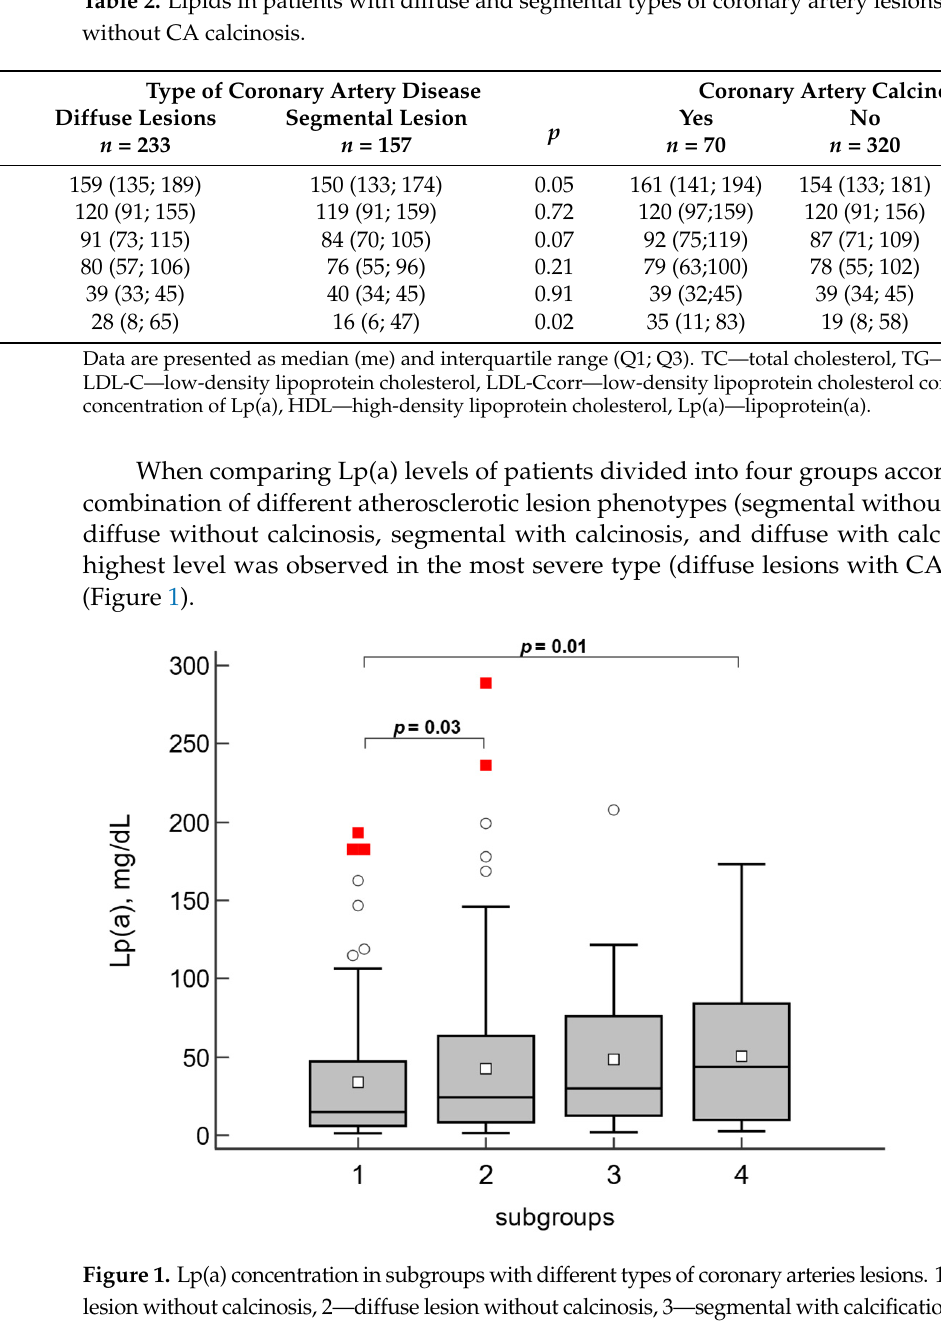
Figure 1. Lp(a) concentration in subgroups with different types of coronary arteries lesions. 1—segmental lesion without calcinosis, 2—diffuse lesion without calcinosis, 3—segmental with calcification, 4—diffuse with calcinosis. The data are presented as Box and Whisker graph. The circles indicate values outside the Q3 + 1.5 interquartile range (IQR), the red squares—values exceeding Q3 + 3 IQR. According to the ROC analysis, an Lp(a) concentration of more than 33 mg/dL was associated with the presence of diffuse CA lesions (sensitivity of 48%, specificity of 68%), with calcinosis of CA (sensitivity of 54%, specificity of 61%), and their combination (sensi- tivity of 60%, specificity of 70%). Compared to the patients with Lp(a) levels < 30 mg/dL, among patients with hyperLp(a), diffuse lesions with CA calcinosis were significantly more common, while segmental lesions without calcinosis were less common (Figure